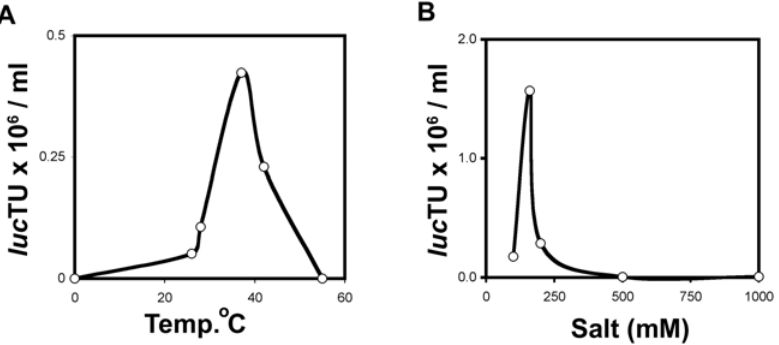
Figure 1. Parameters affecting the in vitro packaging reaction. Effect of temperature (A) and concentration of monovalent salts (B) present during the re-association reaction (step B) on the yield, measured as titer of luc transducing units.